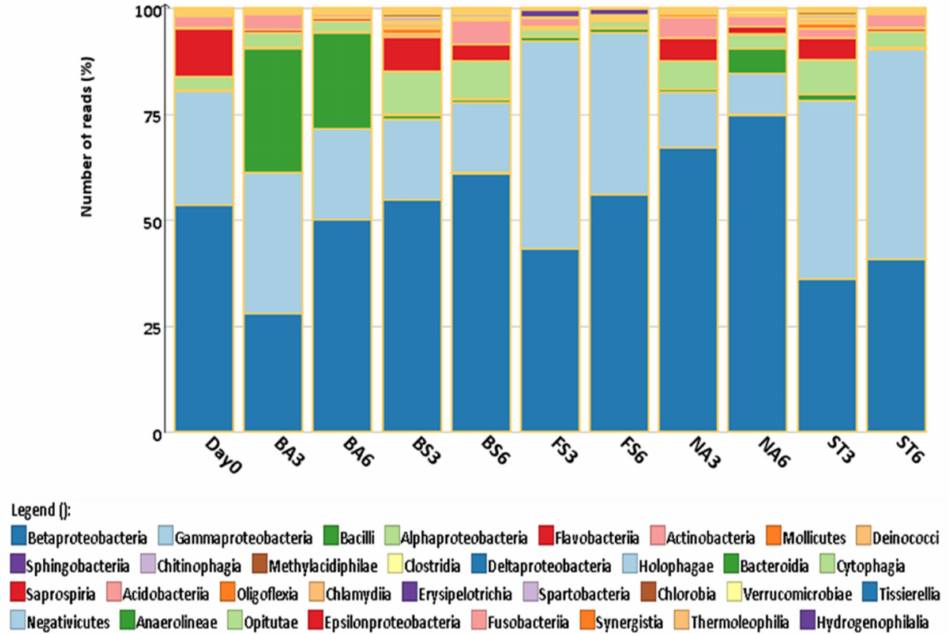
Figure 6. Variation in abundance of dominant bacterial classes at Day 0, week 3 and week 6 of different treatments assessed by 16S DNA sequencing analysis. NA: Natural attenuation; FS: Fusarium solani ; BS: Biostimulation; BA: Bacilli, ST: Streptomyces ; 3, 6: